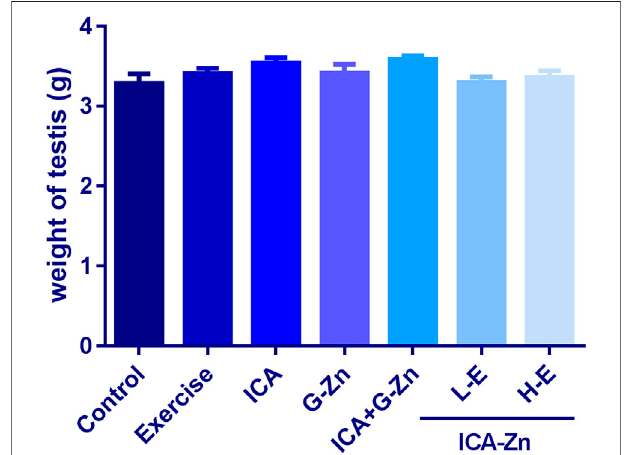
FIGURE 8 | Effect of icariin-zinc on testicular index of rats ( n (cid:2) 8, mean ±